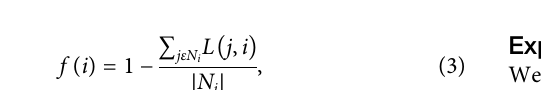
FIGURE 4 | Our approach identi fi es the most salient regions in different classes for image classi fi cation using AlexNet. From top to bottom: original image, MARGIN ’ s explanation overlaid on the image, and Grad-CAM ’ s (Selvaraju et al., 2017) explanation. Note our approach yields highly speci fi c, and sparse explanations from different regions in the image for a given